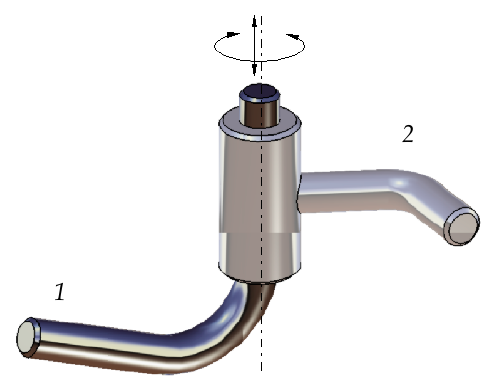
Figure 2. Cylindrical joint between the parts 1 and 2.